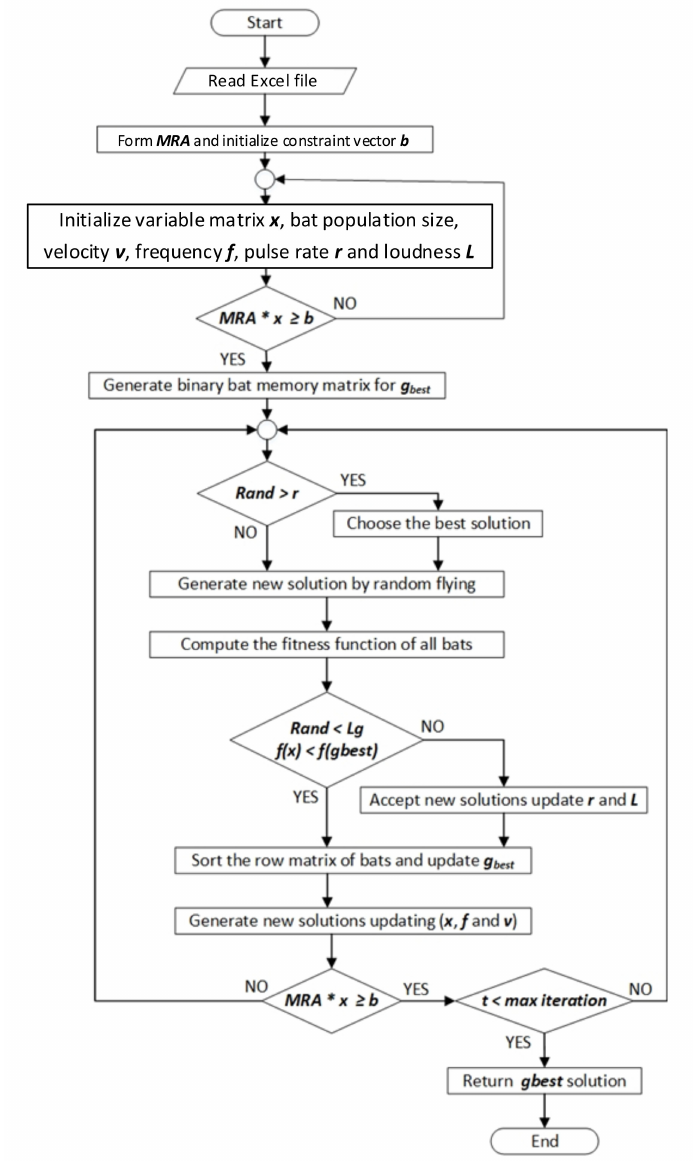
Figure 3. Flowchart for determining the optimal location and the number of dip